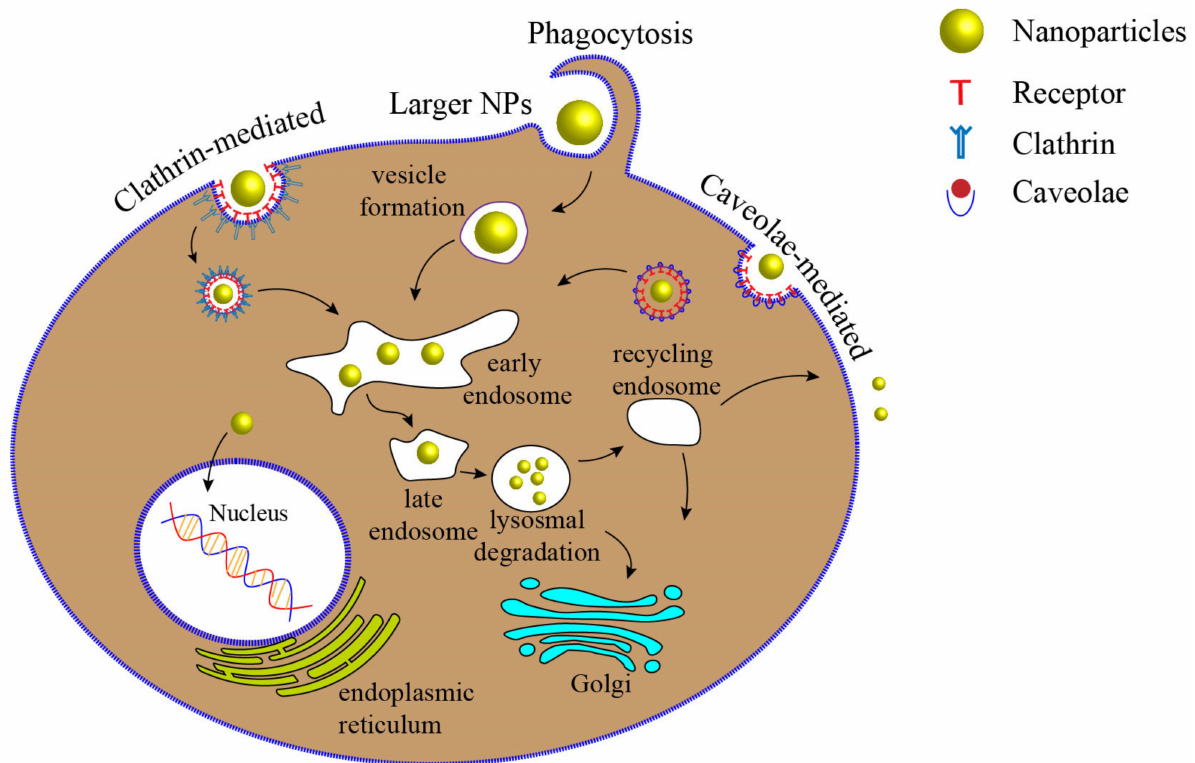
Figure 2. Different endocytosis mechanisms by which NPs can enter cells. Larger particles can be taken up by phagocytosis, while smaller particles can bind to some proteins such as Clathrin and Caveolae on the membrane of cells and enter cells. NPs are engulfed with the cell membrane and entrapped in the cellular vesicle. Then, the vesicles are uncoated and delivered to specialized intracellular components. Early endosomes fuse vesicles and transport particles to different destinations. The early endosome next matures down to the late endosome, and they fuse with lysosomes